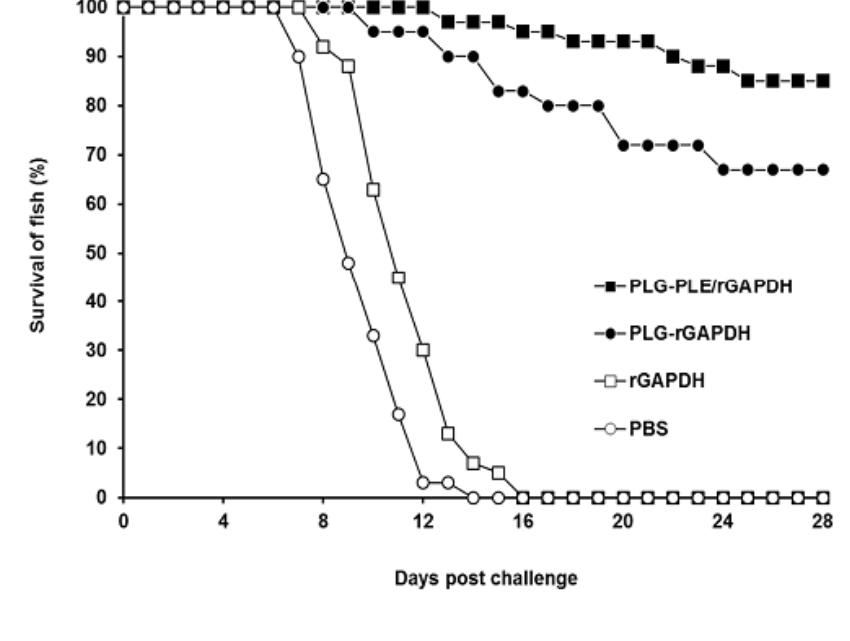
Figure 7. Survival of immunized grouper after a lethal V. harveyi challenge. Grouper were intraperitoneally immunized twice with PLG-PLE/rGAPDH microparticles (■), PLG-rGAPDH microparticles (●), rGAPDH alone (□) or PBS (○). Nine weeks after boosting, four groups of 60 groupers each were intraperitoneally infected with 6 × 10 6 CFU of V. harveyi (BCRC13812 strain). Fish were observed daily for an additional month (28 days), and the final survival rates were calculated. * p < 0.05 when comparing the PLG-PLE/rGAPDH group to the PLG-rGAPDH